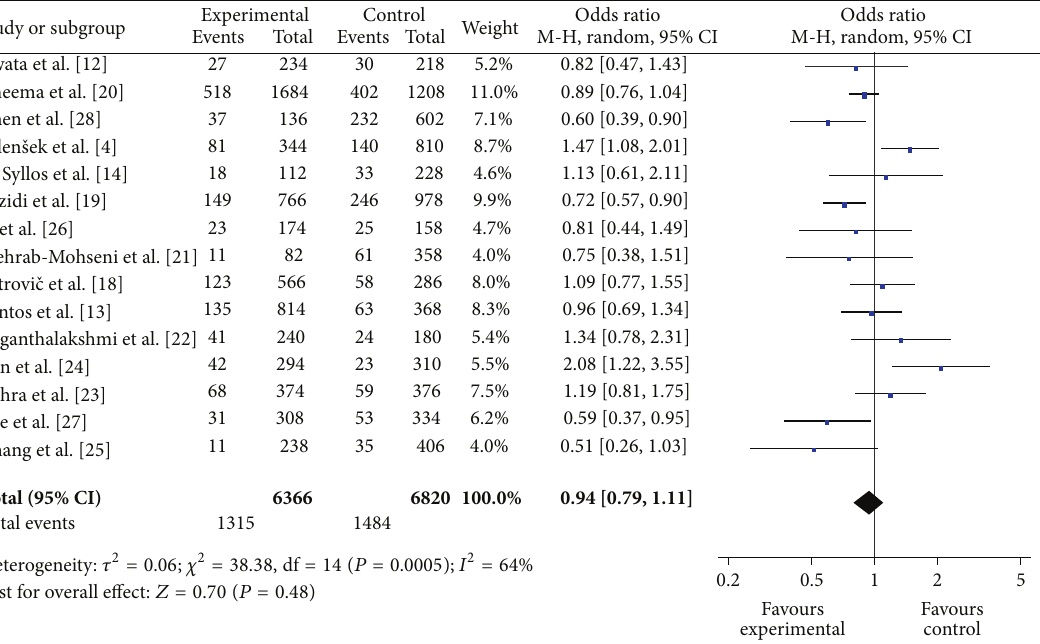
Figure 2: The forest plot of a versus b of eNOS polymorphism and overall DR